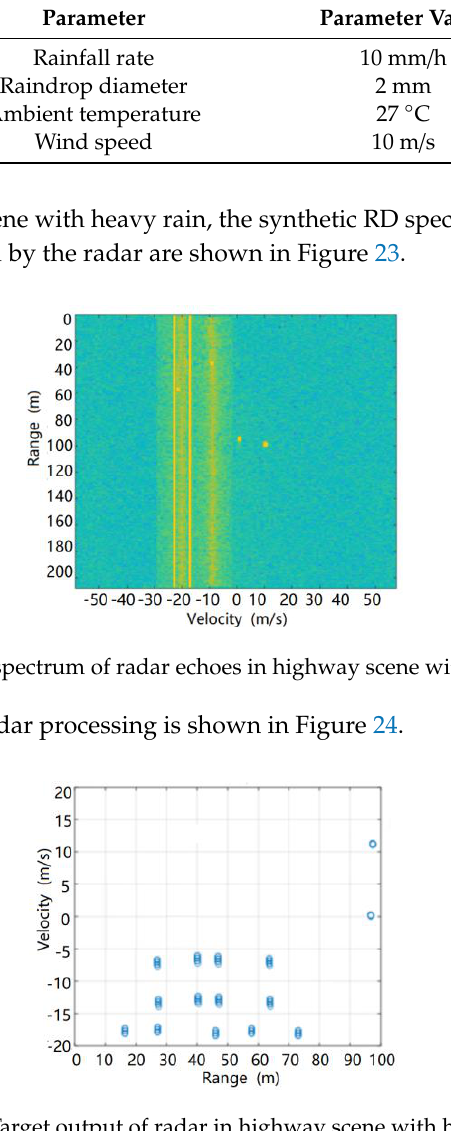
Table 5. Weather parameters in highway scene with heavy rain.